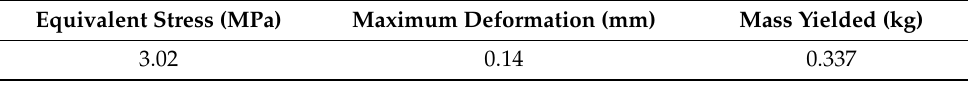
Table 4. Equivalent stress and maximum deformation for modified indigenous model.